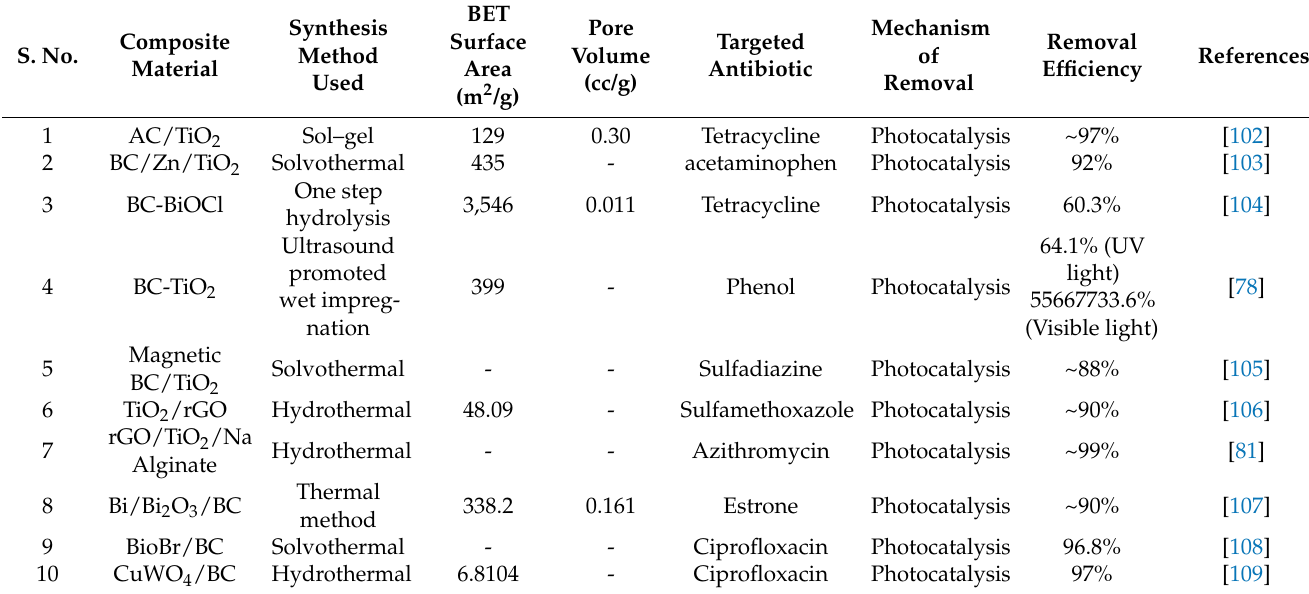
Table 2. Comparison of synthesis methods on the properties of carbon-based TiO 2 nanocomposites and the removal efficiency of